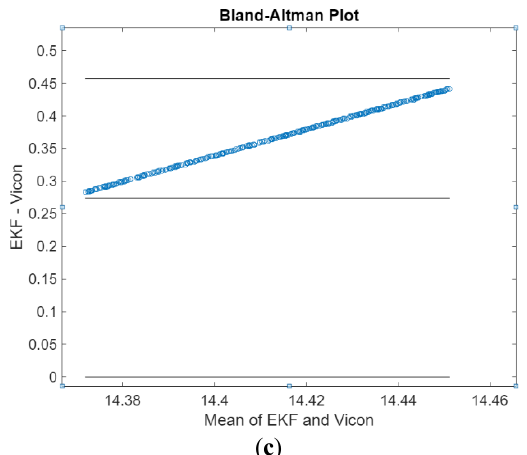
Figure 4. Profile of Euler angles during the fine alignment process (scenario no. 6): ( a ) Heading, ( b ) Pitch, and ( c ) Roll.